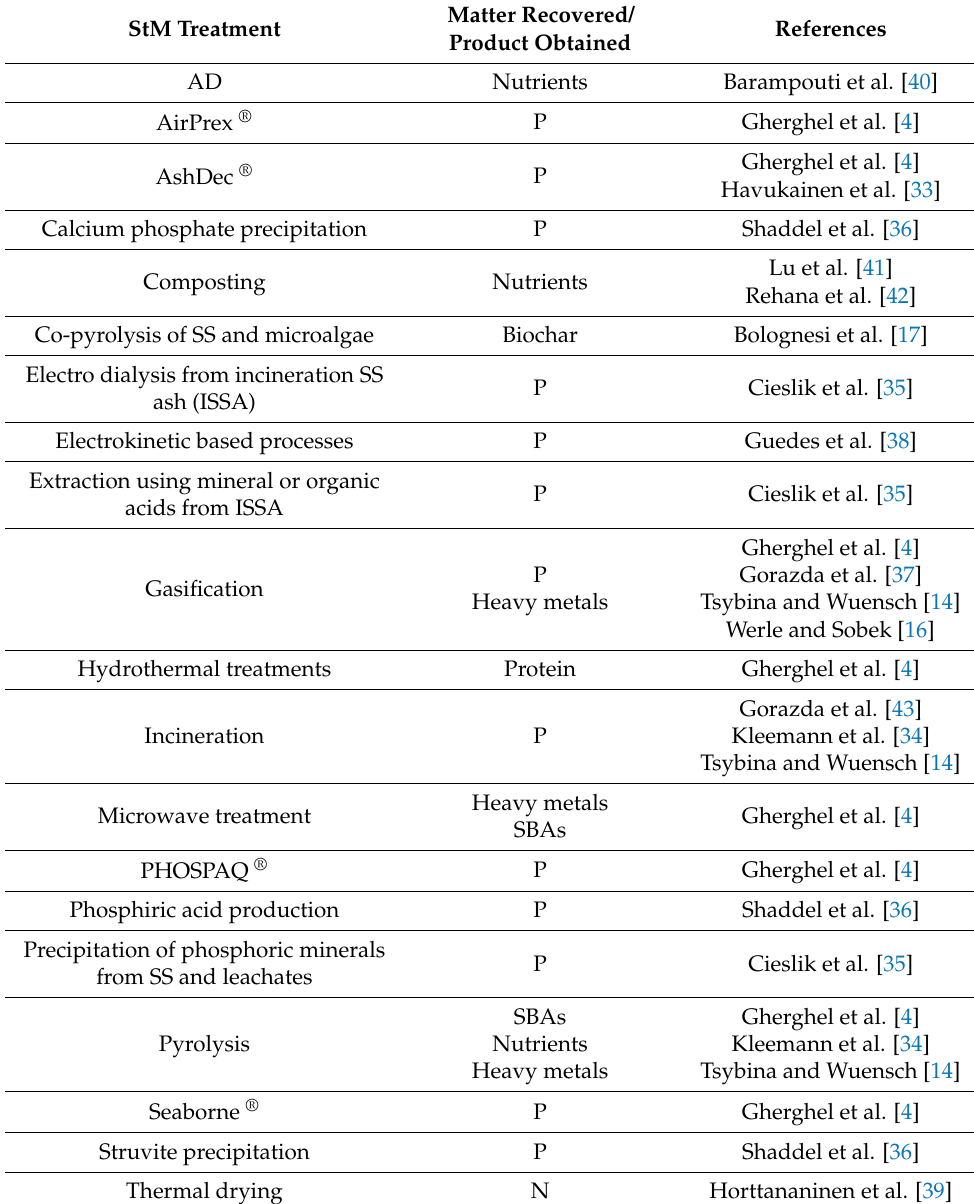
Table 2. Summary of the sludge-to-matter (StM)